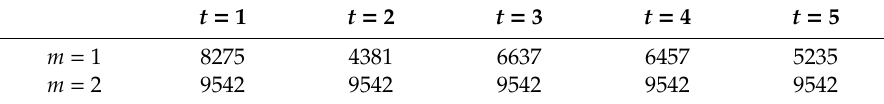
Table 20. Inventory level at each manufacturing plant in each time